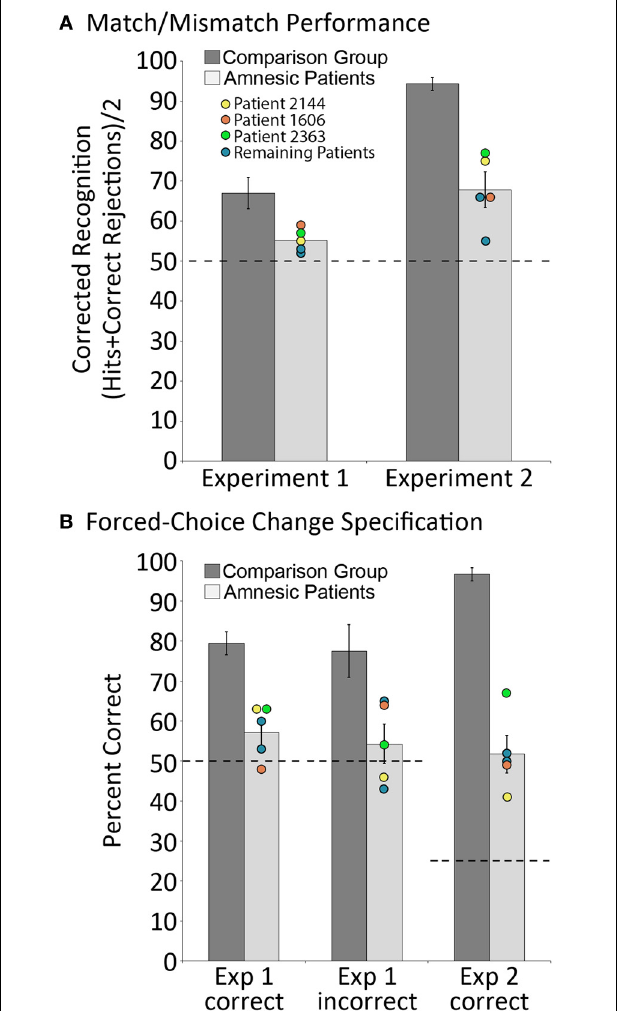
FIGURE 3 | Behavioral results. (A) corrected recognition on the match/mismatch test in Experiments 1 and 2, for amnesic patients (light gray bars) and comparison participants (dark gray bars); (B) proportion correct on the change specification test in Experiments 1 and 2, contingent on whether mismatching scenes were successfully identified (“Correct”) or not (“Incorrect”), for amnesic patients (light gray bars) and comparison participants (dark gray bars). Individual performances for each patient are indicated, and the performances of three patients with noteworthy anatomical profiles—one with damage limited to hippocampus (2144, yellow) and two with more extensive damage that includes either the parahippocampal region (1606, orange) or the parietal lobe (2363, green)—have been highlighted. Error bars represent standard error of the mean. Dashed lines represent chance level